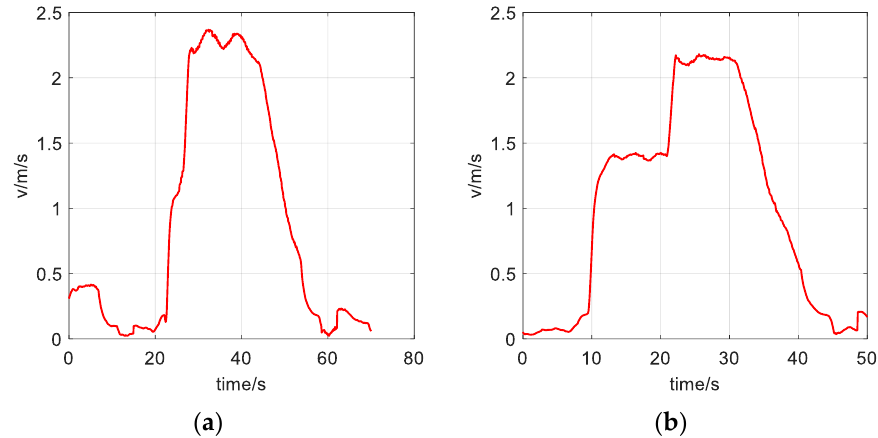
Figure 22. The velocity variations curve of ASV: ( a )forward, ( b )left and forward.